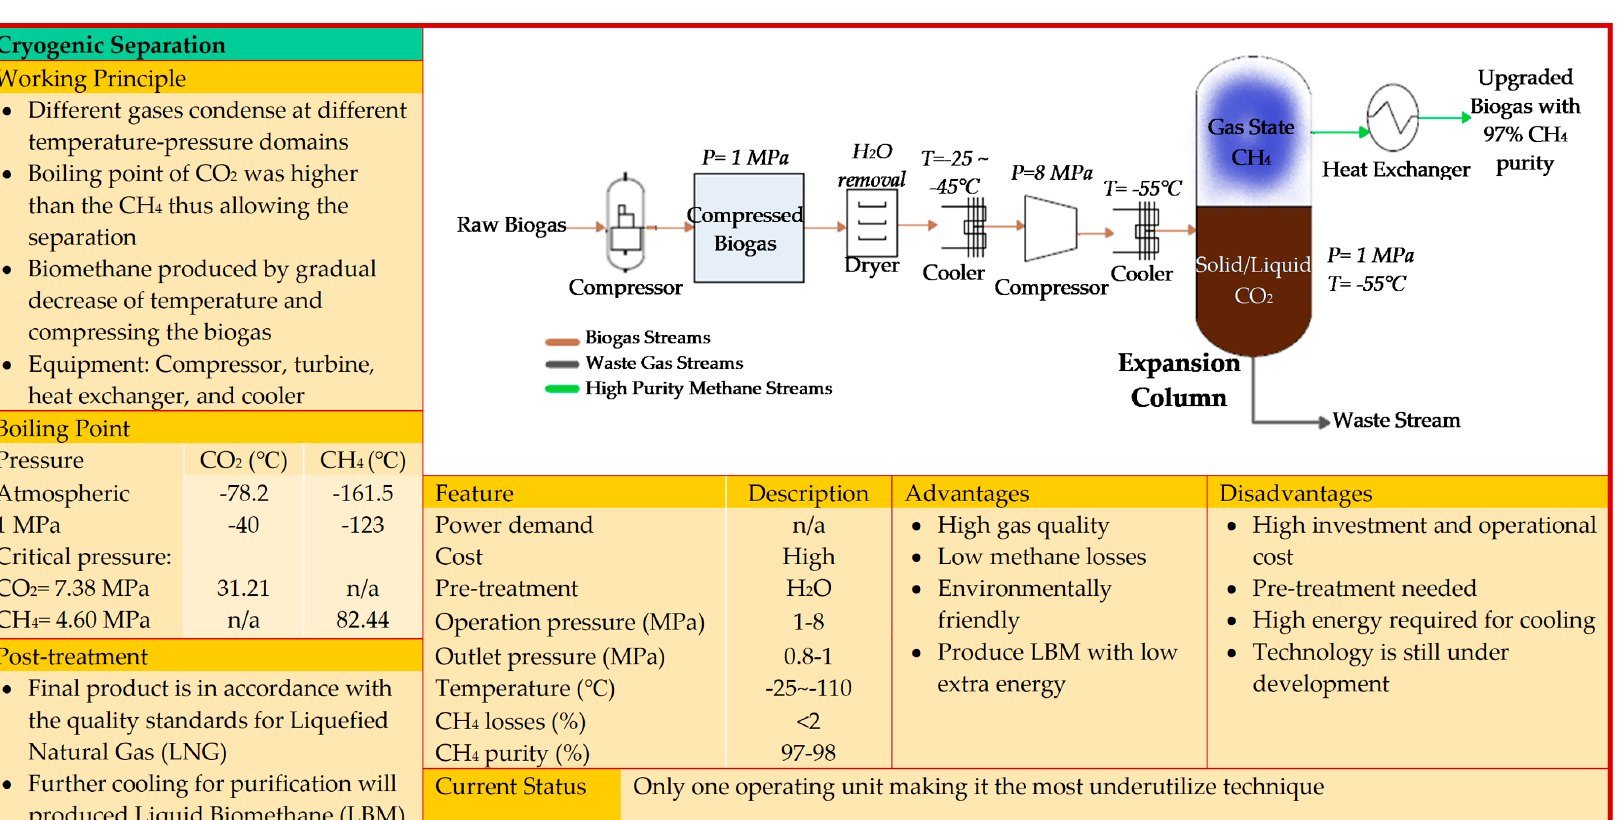
Figure 6. Depicts fundamental knowledge on cryogenic separation [15,19,20,25,28,29,40–43].